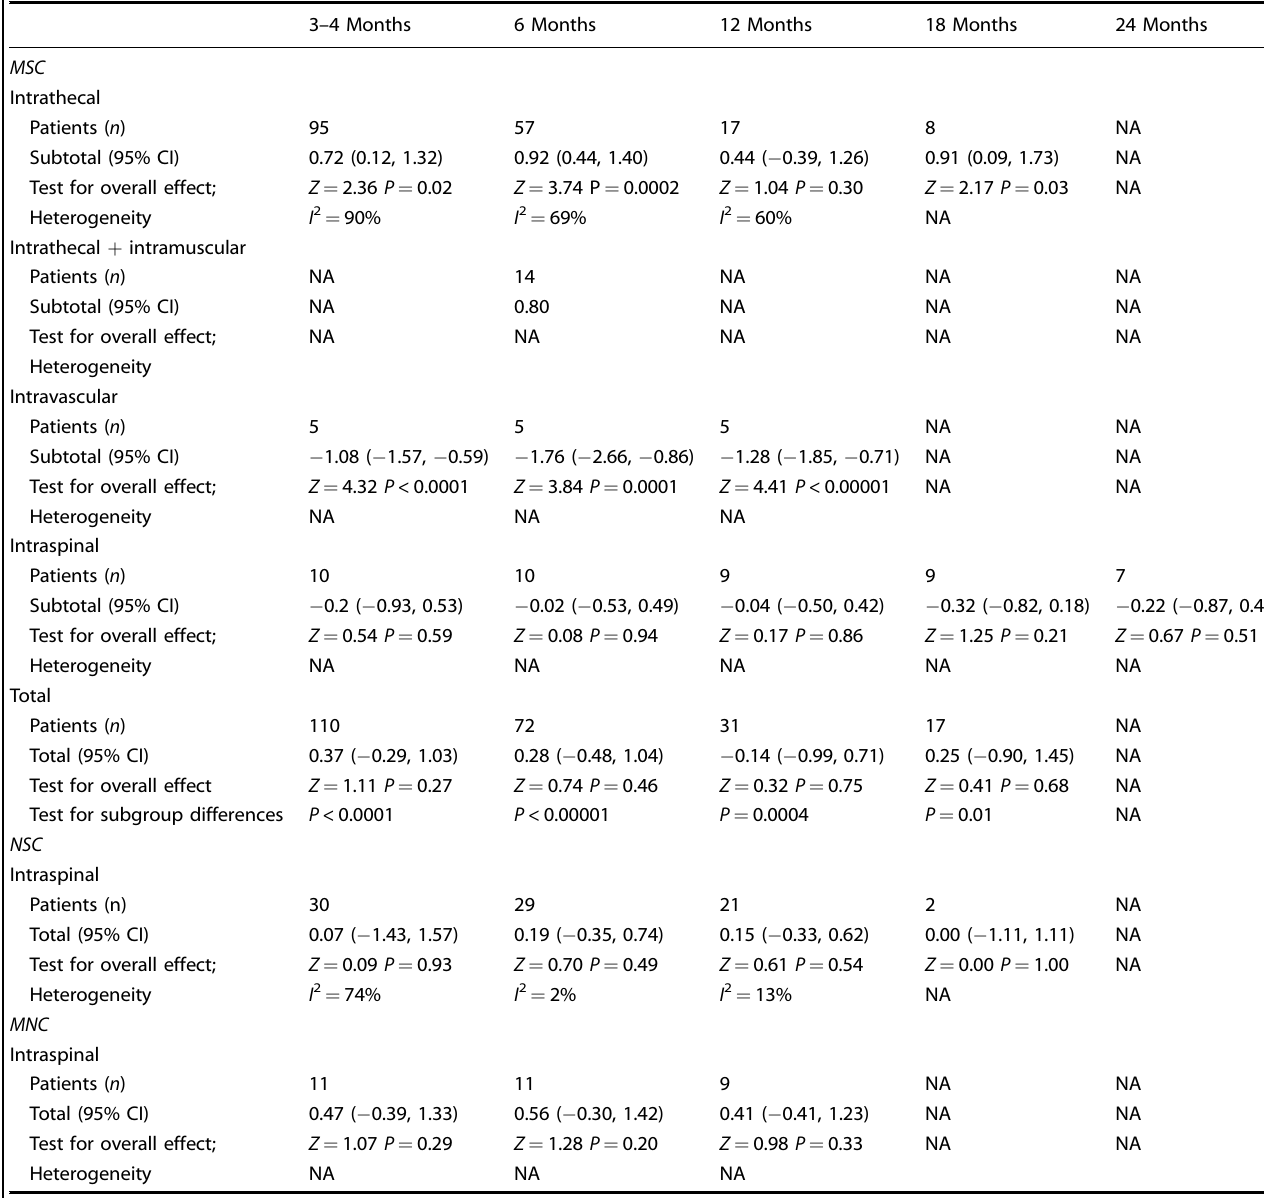
Table 2. Differences in ALSFRS-R change, in points per month, between the lead-in and follow-up